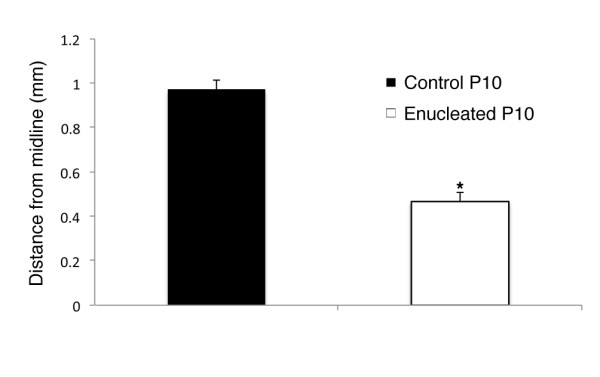
Analysis of somatosensory INC position within the medial parietal cortex of control and enucleated mice. Following placement of DiA or DiI crystals into the somatosensory cortex and time for retrograde transport of tracer, the straight-line distance from the midline edge of layer 1 of the neocortex to the most medial retrogradely labeled cell was measured using precision micrometry. Enucleated animals exhibited a distinct extension of labeling from the somatosensory cortex into the visual cortex, resulting in a reduced distance to midline (0.46 ± 0.04 mm; df = 12; n = 7) when compared to controls (0.97 ± 0.04 mm; df = 12; n = 7; P < 0.01; two-sample t-test). DiA: 4-(4-(dihexadecylamino)styryl)-N-methylpyridinium iodide; DiI: 1,1'-dioctadecyl-3,3,3',3'-tetramethylindocarbocyanine perchlorate; INC: ipsilateral intraneocortical connection.